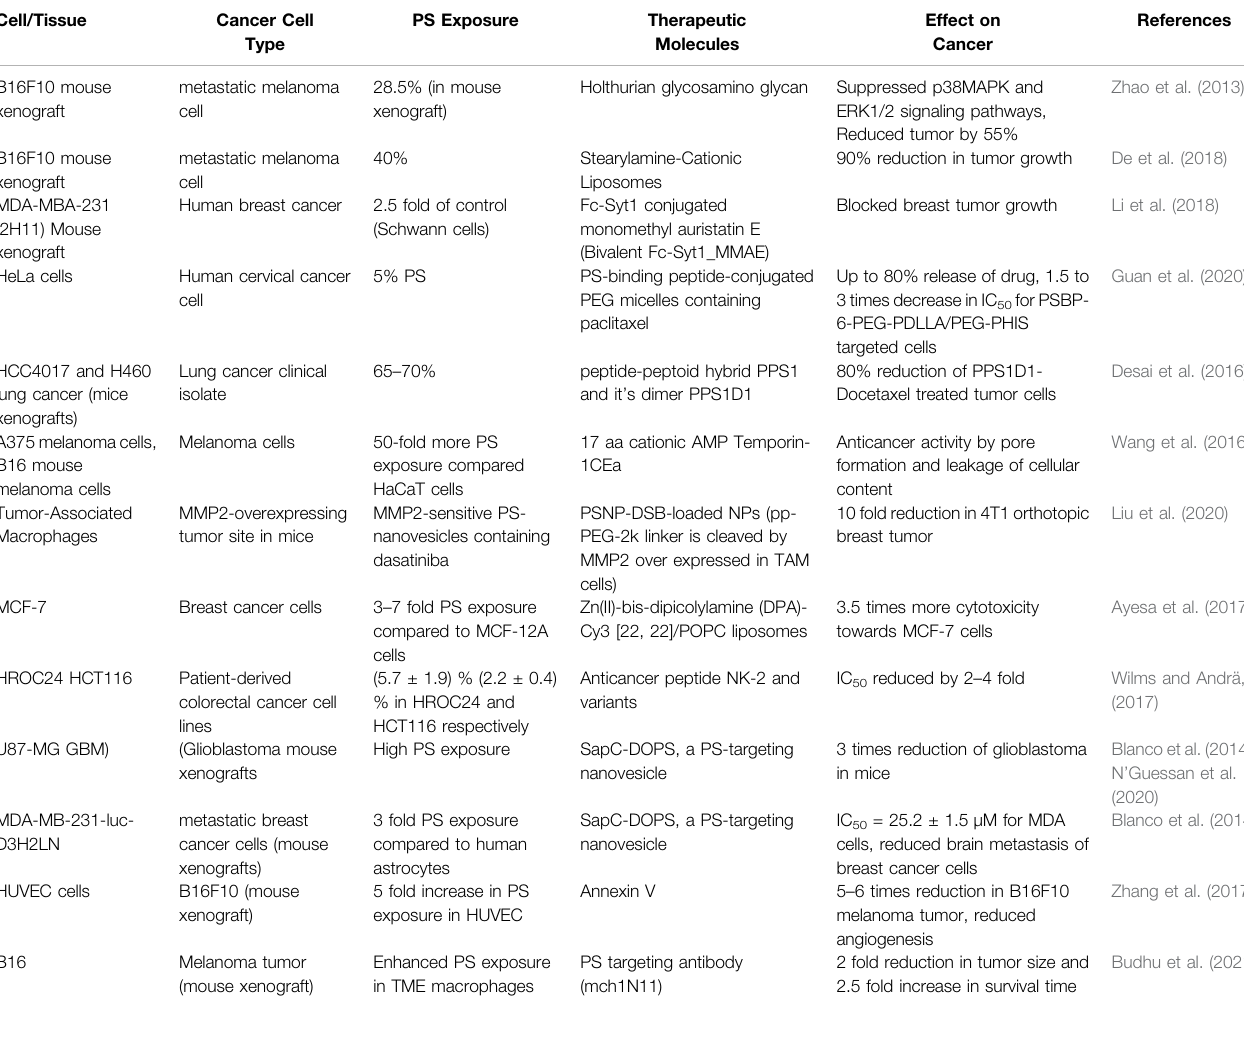
TABLE 3 | Targeting the cell surface PS for anticancer